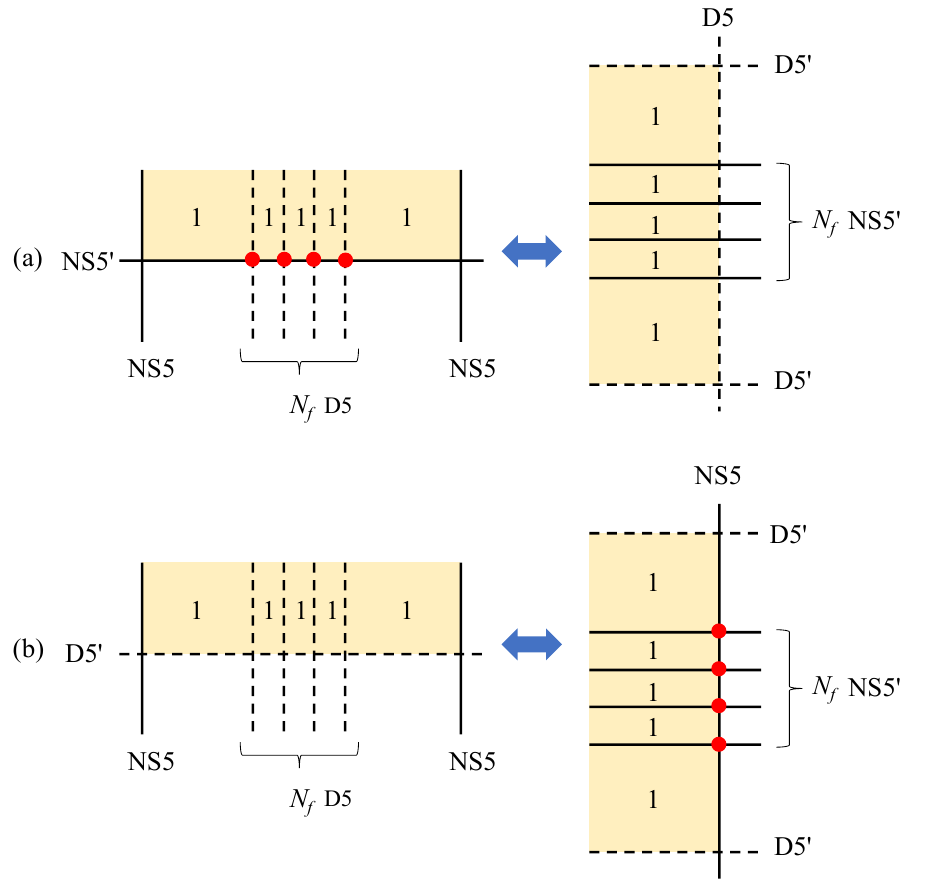
Figure 9 . (a) The brane constructions of the Neumann b.c. ( dual Dirichlet b.c. (